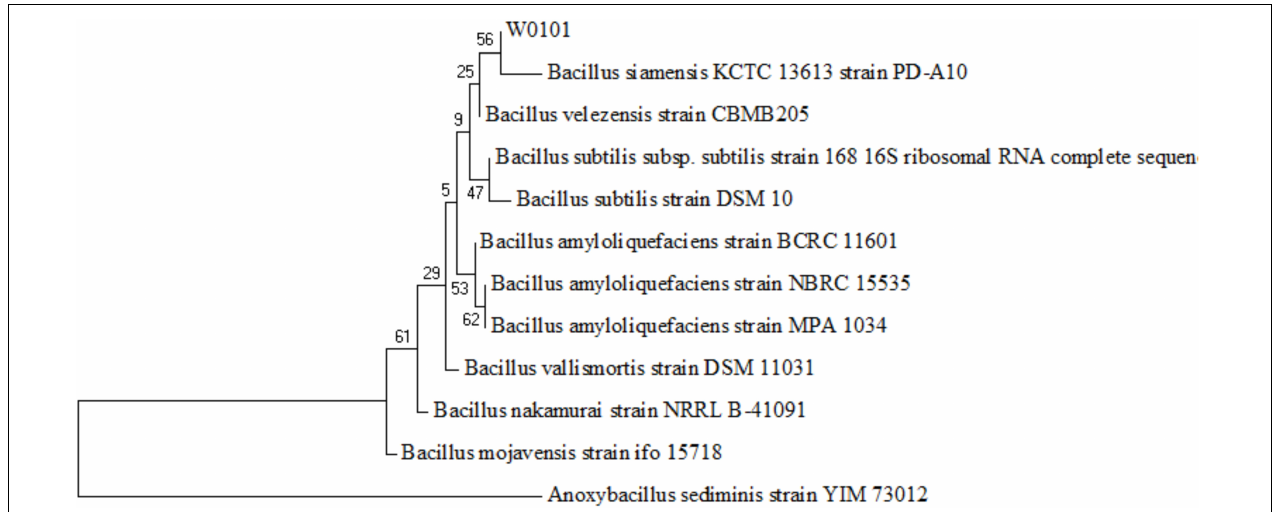
FIGURE 2 | Phylogenetic tree of the strain W0101 based on the 16S rRNA gene sequences. The tree is constructed with the maximum likelihood estimate method by the MEGA 7 software. The numbers on the nodules represent frequency of 1,000 bootstrap replicates.